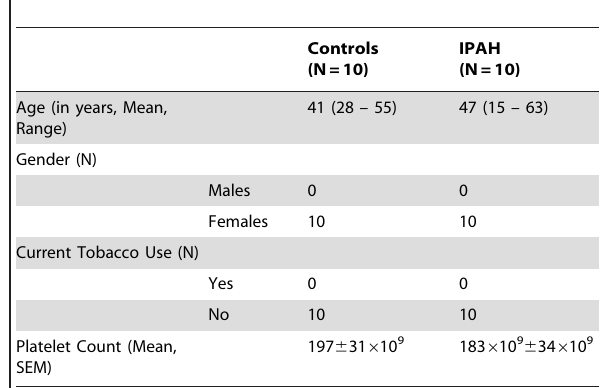
Table 1. Sample Characteristics.